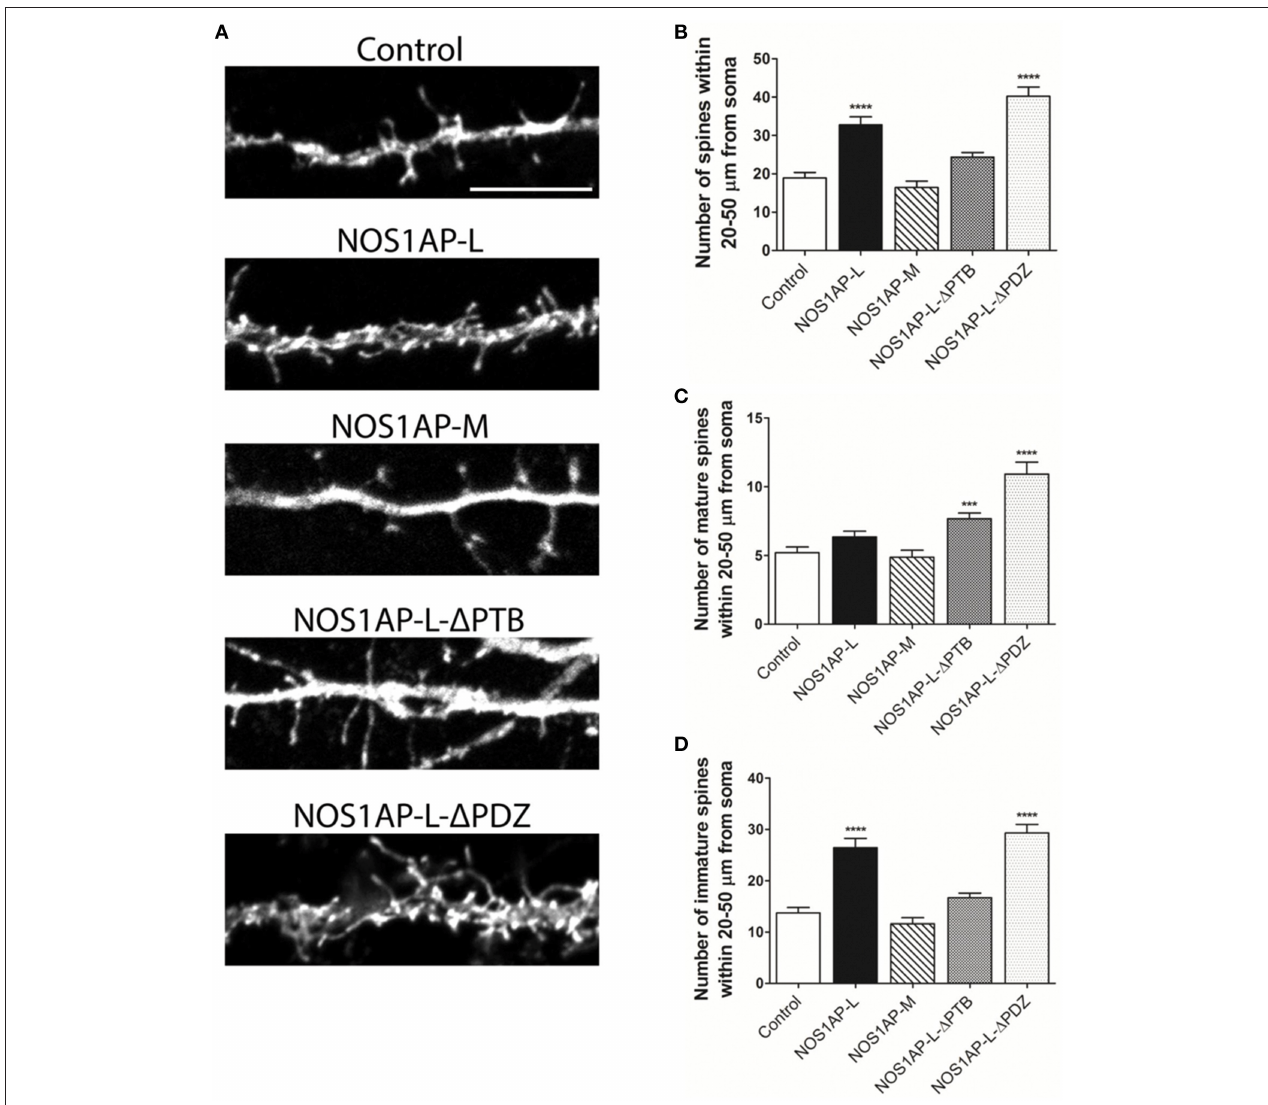
FIGURE 5 | NOS1AP-L alter spine number and morphology. (A) Representative images of dendrites from rat cortical neurons (DIV 17) transfected with pCAG-GFP (control), pCAG-GFP-NOS1AP-L, pCAG-GFP-NOS1AP-M, pCAG-GFP-NOS1AP-L- 1 PTB, or pCAG-GFP-NOS1AP- 1 PDZ. Scale bar = 10 µ m. (B) Number of spines per 30 µ m segment in cultured neurons expressing indicated proteins. **** p < 0.0001 vs. GFP. p -values were determined by one-way ANOVA followed by Bonferroni Multiple Comparisons test. Error bars indicate ± s.e.m. (C) Number of mature spines per 30 µ m segment in cultured neurons expressing indicated proteins. *** p < 0.001 and **** p < 0.0001 vs. GFP. p -values were determined by one-way ANOVA followed by Bonferroni Multiple Comparisons test. Error bars indicate ± s.e.m. (D) Number of immature spines per 30 µ m segment in cultured neurons expressing indicated proteins. **** p < 0.0001 vs. Control. p -values were determined by one-way ANOVA followed by Bonferroni Multiple Comparisons test. Error bars indicate ± s.e.m. n = 50 dendrites, GFP; n = 41, NOS1AP-L; n = 50, NOS1AP-S; n = 37, NOS1AP-M; n = 55, NOS1AP-L- 1 PTB; n = 35, NOS1AP- 1 PDZ. Dendrites were analyzed from 12–20 neurons per condition with 2–3